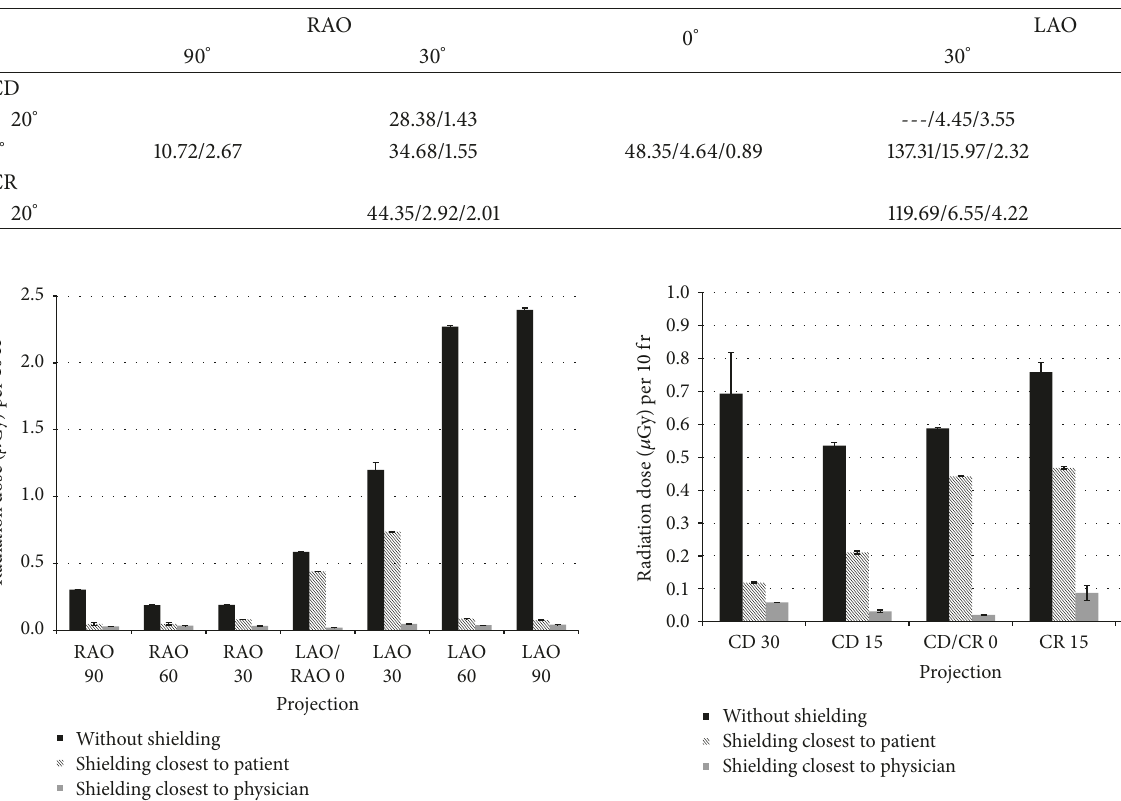
Figure 6: Doses from the scatter radiation in cardiology for LAO/RAO 0 ∘ , CD 30 ∘ to CR 30 ∘